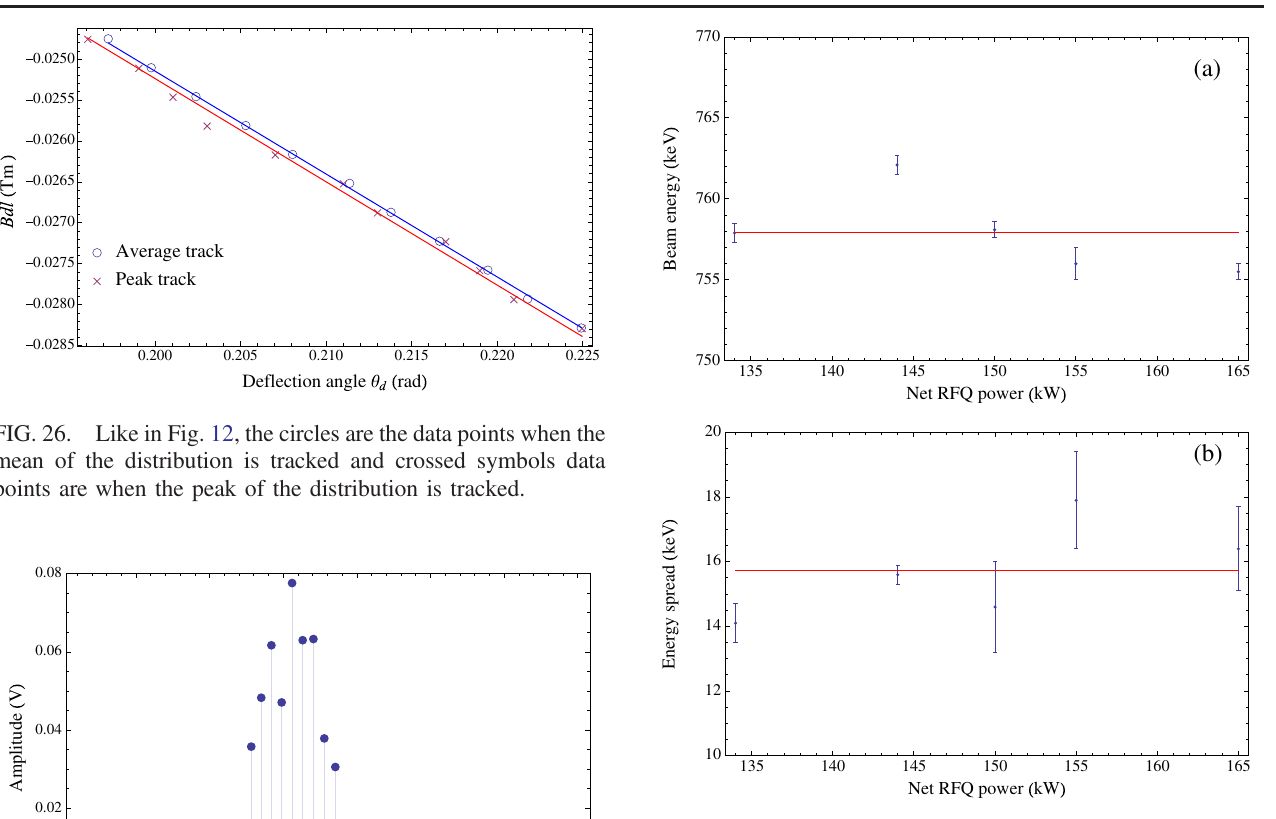
FIG. 28. (a) The mean output energy of the beam (shown here measured with the average tracking method) has a small energy dependence on the net RFQ power. The effect is < 1% . The red line is drawn at 758 keV which is the average energy of all the data points shown here. (b) The average energy spread of the beam is ð 15 . 4 (cid:1) 0 . 4 Þ keV (red line) in this net RFQ power range.